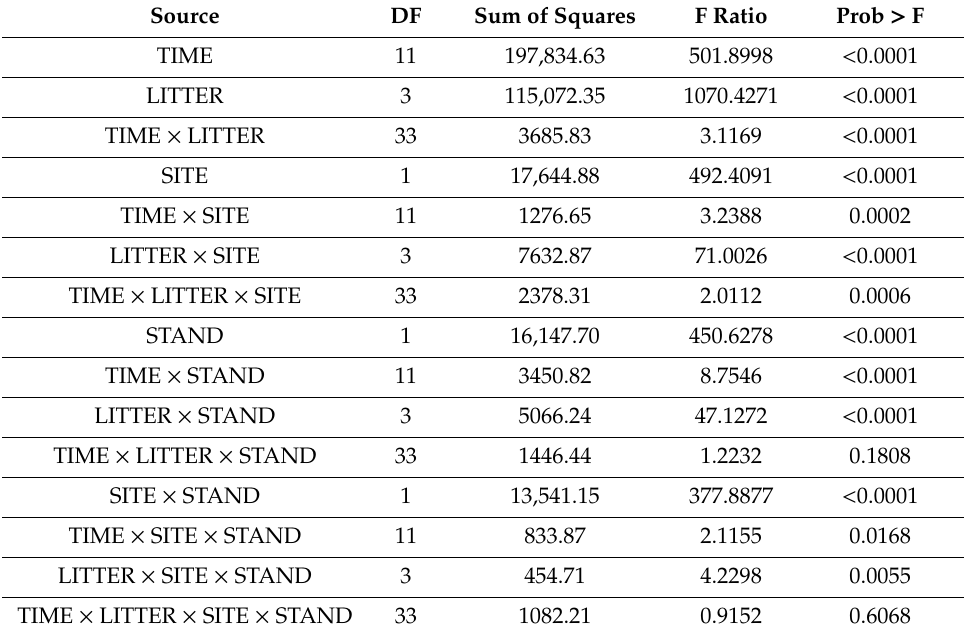
Table 1. E ff ect of leaf litter type (LITTER), collection time (TIME), stand type (STAND), site type (SITE), and their interactions on decomposition rates as a result of analysis of variance (ANOVA). DF—degrees of